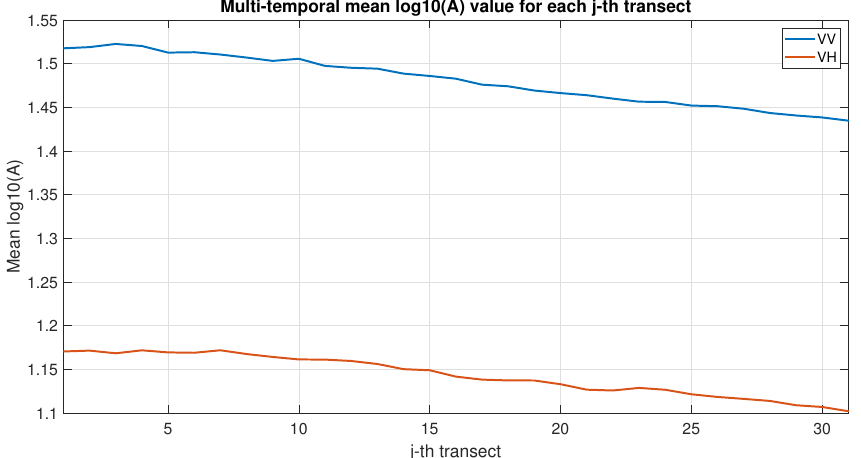
Figure 13. Mean amplitude value (VH and VV polarizations) on the transects parallel to the coastline. A decreasing trend can be noticed for both polarizations moving from the dry transect ( j = 1) towards the sea ( j = 33).